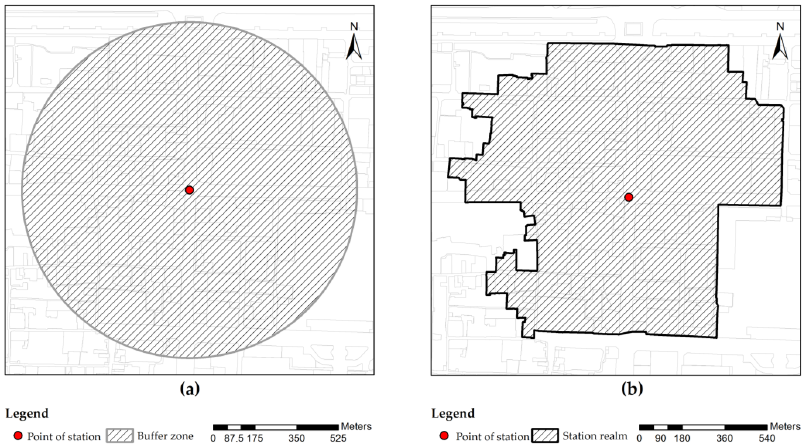
Figure 5. The scope adjustment process of the BDJ station realm: ( a ) before adjustment; ( b ) after adjustment.